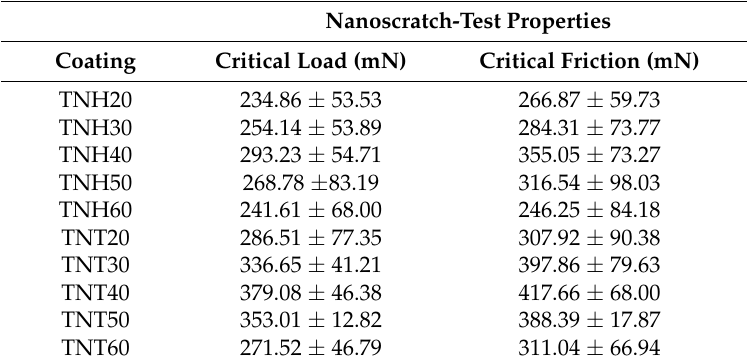
Table 2. Results of nano scratch-tests of Ti6Al4V/TNH20-60 and Ti6Al4V/TNT20-60 systems. Nanoscratch-Test